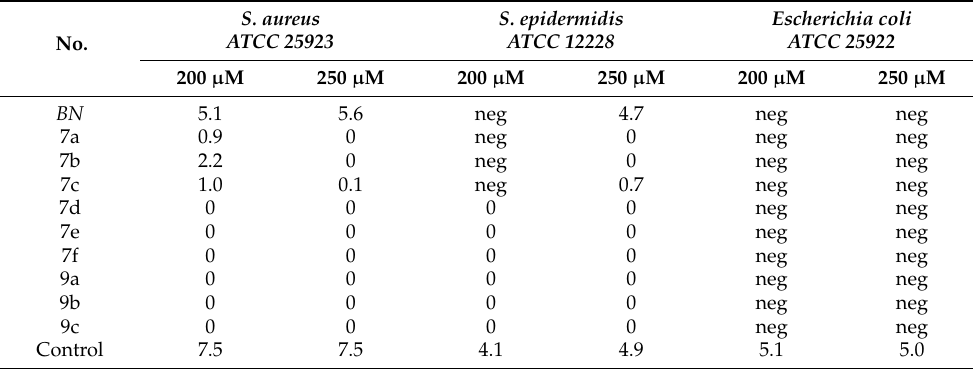
Table 3. The results of the antimicrobial analysis using Gram-positive and Gram-negative bacteria cultured with the investigated compounds at 37 ◦ C for 18 h. The results are presented as the differ- ences between the optical density measurements of the samples before and after culture ( McFarland’s scale